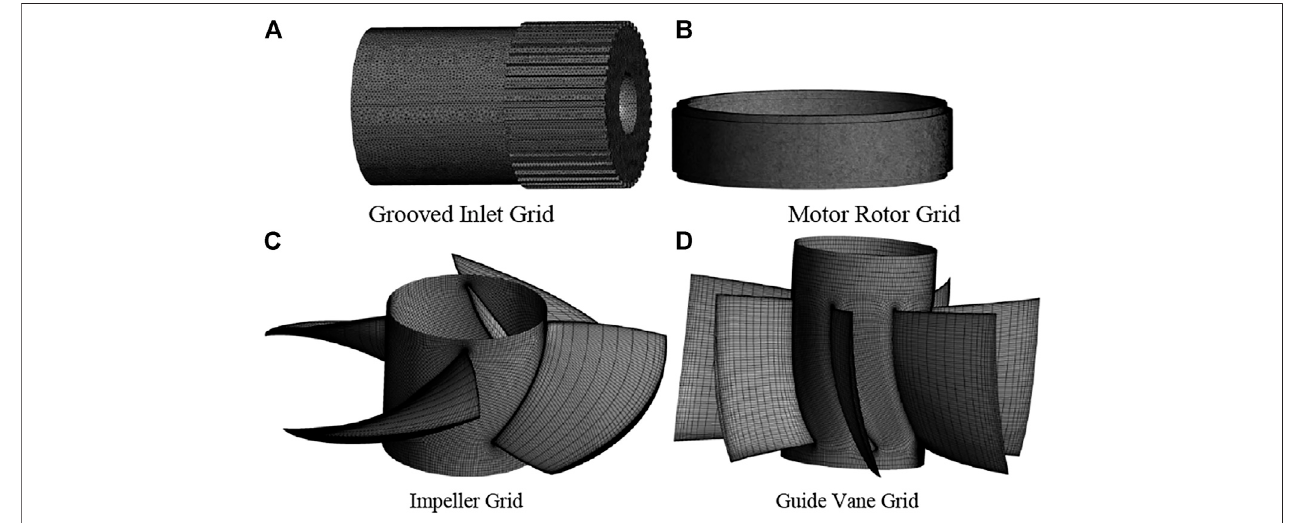
FIGURE 2 | Meshing of the main components of the computational domain. (A) grooved inlet grid, (B) motor rotor grid, (C) impeller grid, (D) guide vane grid.